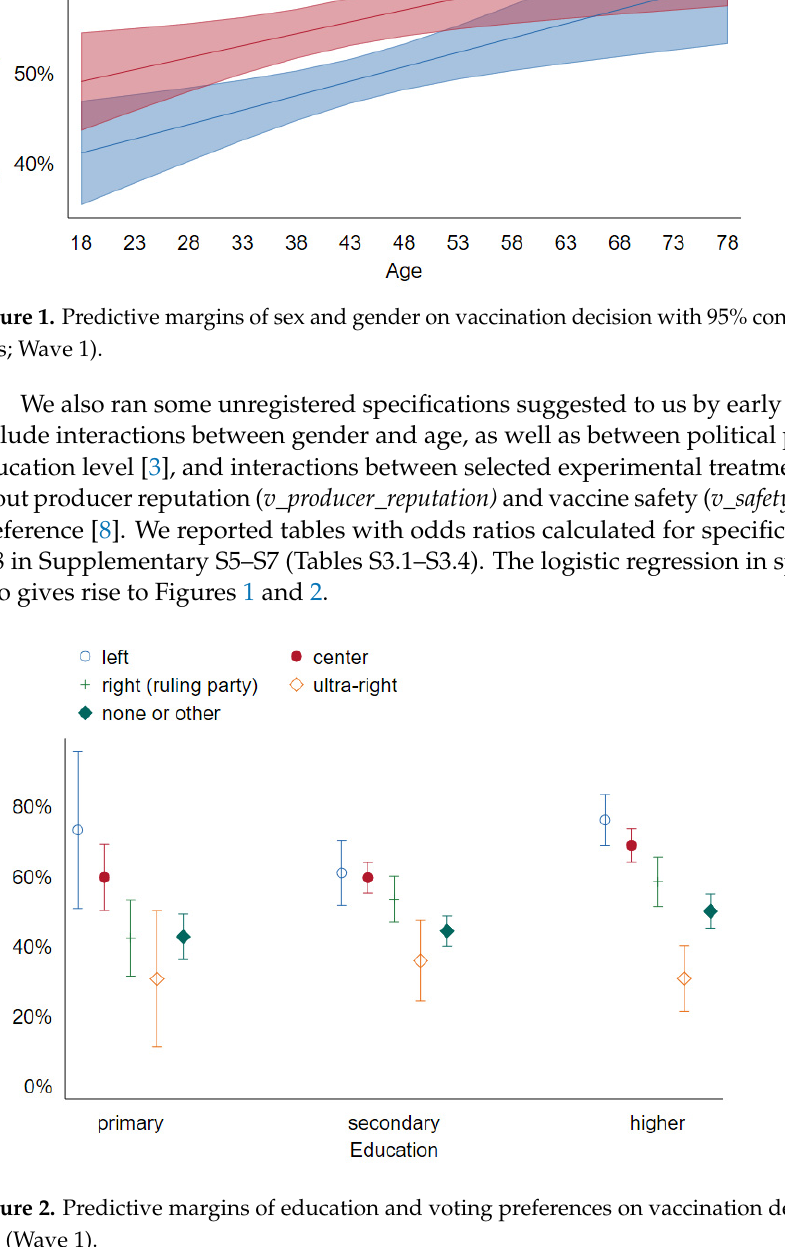
Table 2. Distribution of willingness to get vaccinated. Vaccination Intention